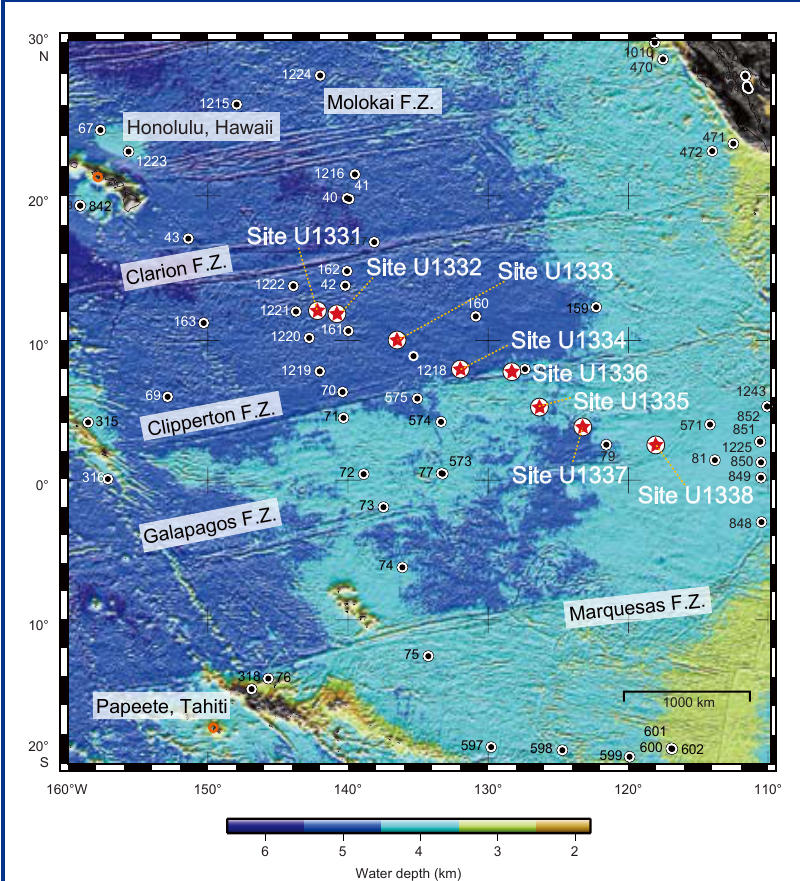
Figure 1A. Present locations of Pacific Equatorial Age Transect (PEAT) drill sites (red stars) on a bathymetric map of the central Pacific. Also shown are locations of previous DSDP and ODP drilling (solid black circles), as well as Honolulu, Hawaii and Papeete, Tahiti (open red circles). F.Z. = fraction